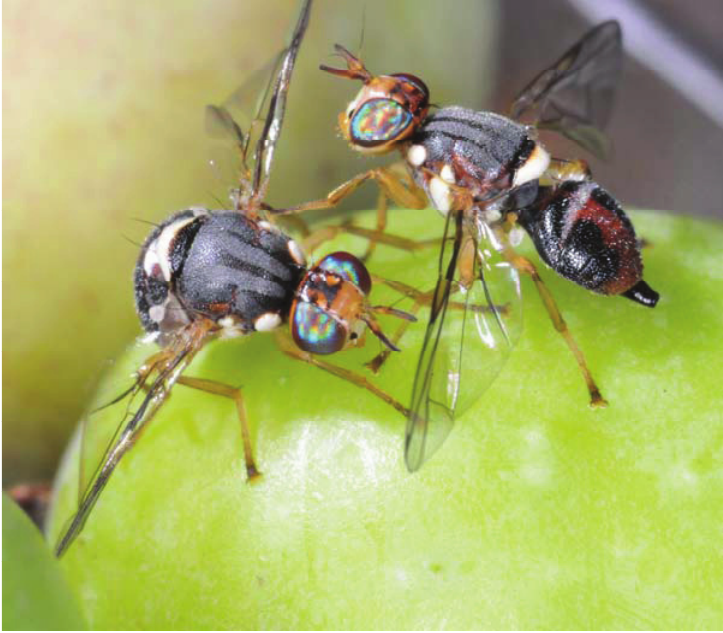
Figure 1. Females of the olive fruit fly, Bactrocera oleae , boxing for an olive fruit (adapted with permission from